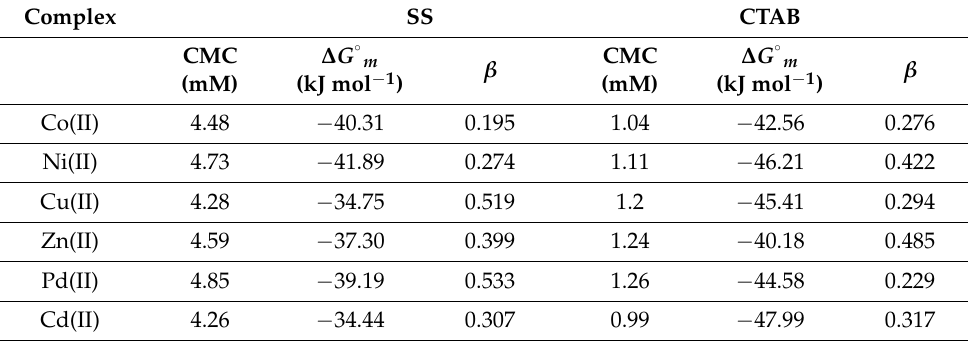
Table 3. Micellar attributes of the metal complex in surfactants at 298 K.